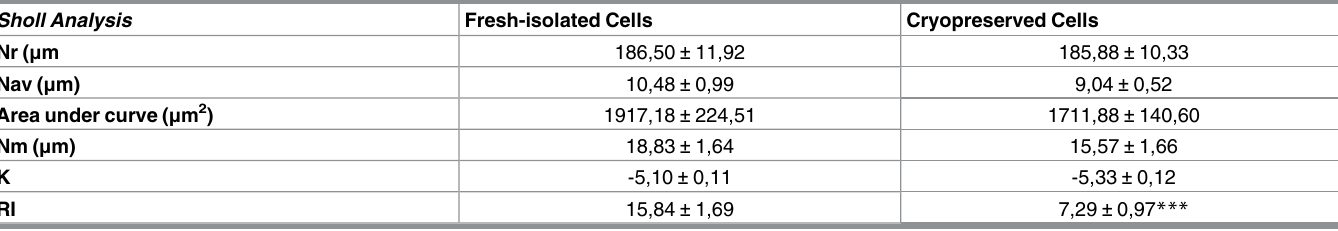
Table 2. Morphological analysis of MGE-derived cells after